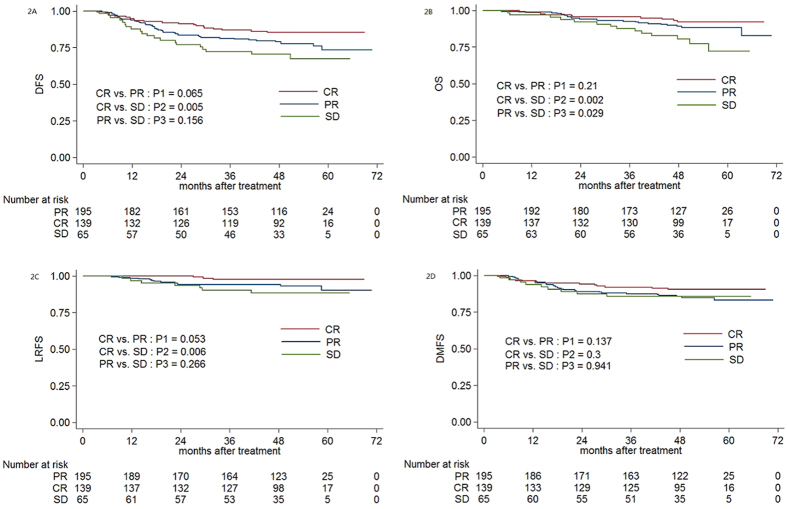
Kaplan-Meier DFS (2A), OS (2B), LRFS (2C) and DMFS (2D) curves for 399 patients with NPC receiving IMRT stratified as the CR, PR and SD groups based on the local tumour response after induction chemotherapy. Abbreviations: DFS = disease-free survival; OS = overall survival; LRFS = local relapse-free survival; DMFS = distant metastasis-free survival. CR = complete response; PR = partial response; SD = stable disease.